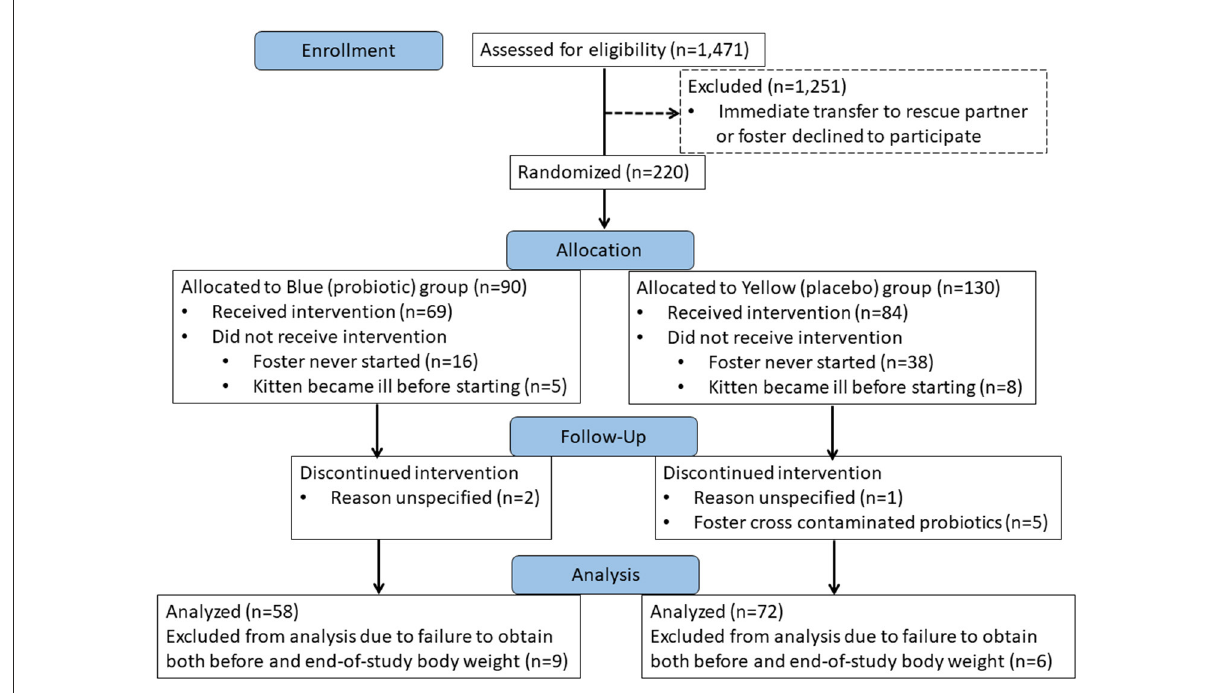
FIGURE1 CONSORT Flow diagram showing disposition of kittens over the course of the